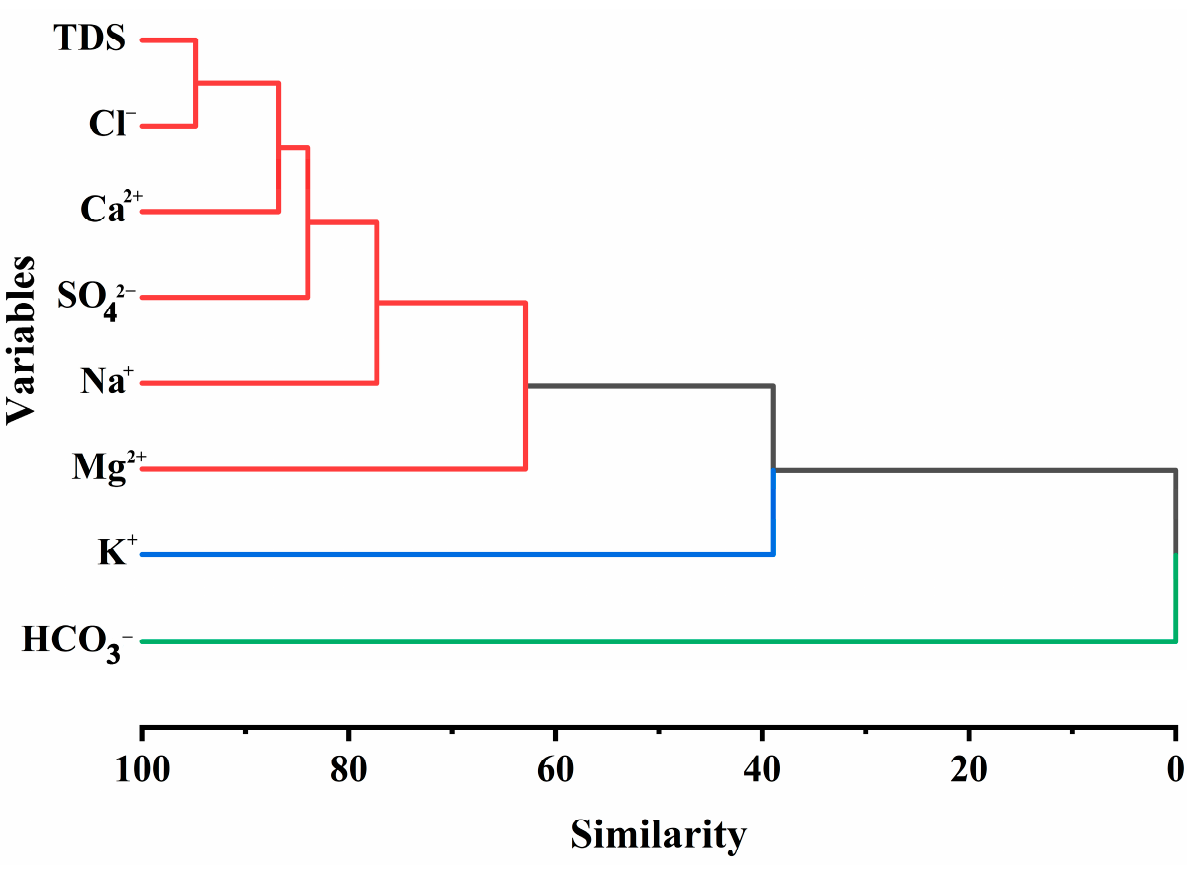
Figure 3. CA dendrogram in R-mode (Variables) for TDS, and major ions in EOC, NS, FB aquifers ( n =